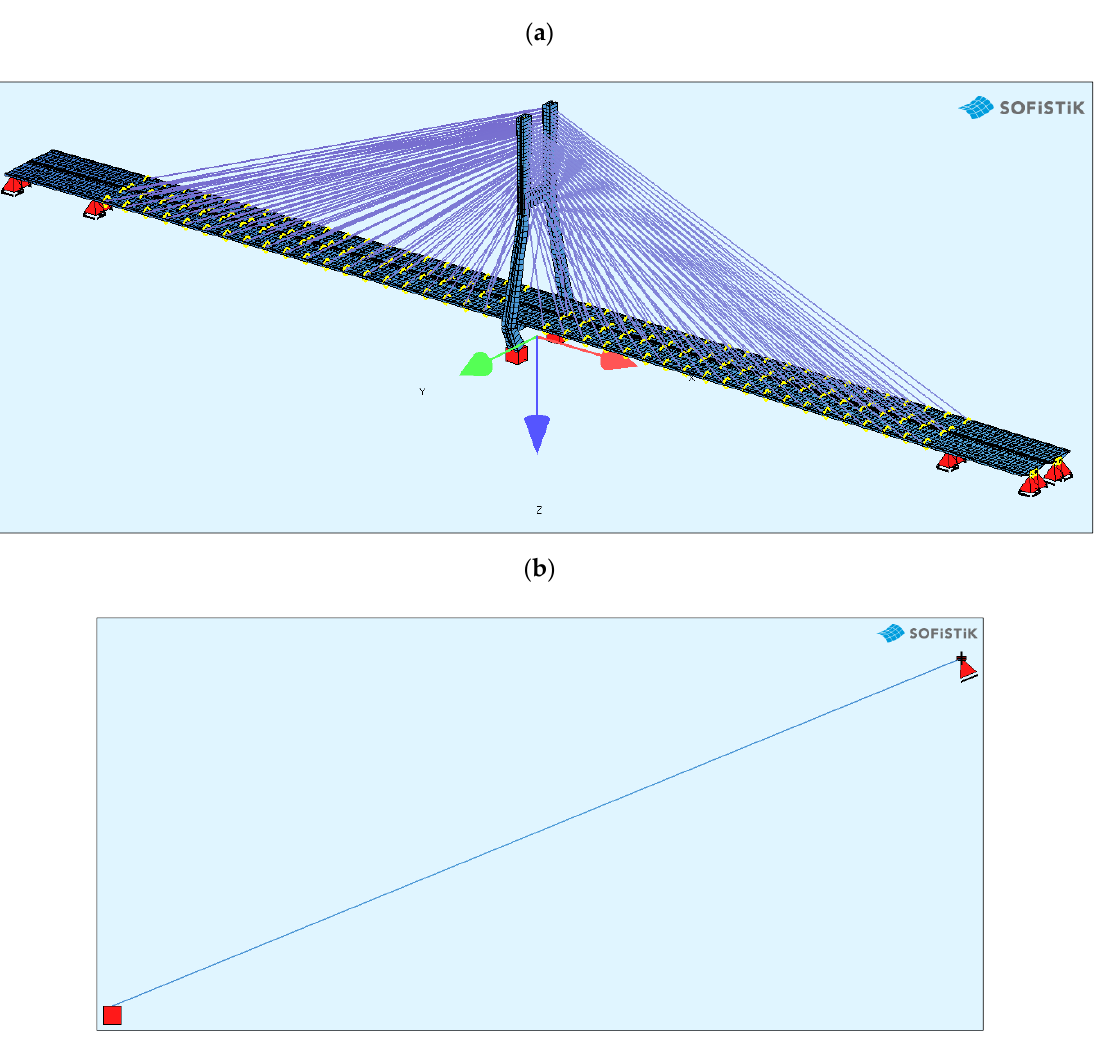
Figure 4. The FEM models: ( a ) the general bridge model; ( b ) a detailed single strand model.